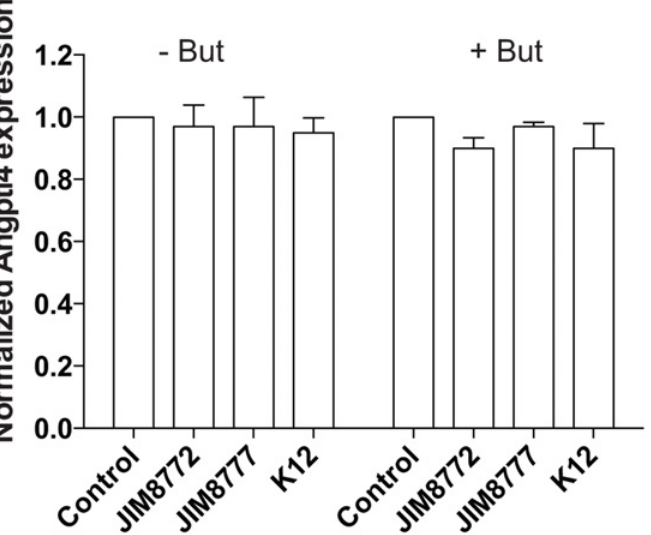
Fig 8. S . salivarius supernatants do not affect PPAR γ -independent ANGPTL4 reporter system. ANGPTL4-reporter system cell-line was activated with sodium butyrate (2mM) with or without S . salivarius supernatant (JIM8772, JIM8777 or K12). Angtpl4 expression was measured by luciferase activity and expressed as fold increase towards its control: growth-medium alone (left panel) and growth-medium + sodium butyrate (right panel). Data are expressed as means ± standard deviations (SD) of triplicate measurements from one representative experiment out of three independent experiments. *** P < 0.001, ** P < 0.005, * P < 0,05 compared with controls (Student's